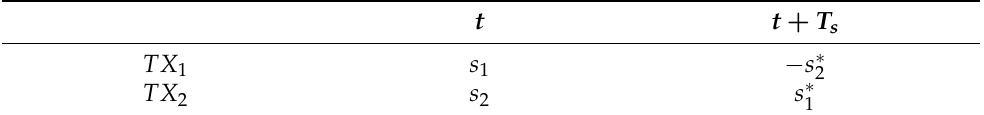
The operator ( · ) ∗ represents the complex conjugate. Table 2. Transmission Alamouti coding operation.